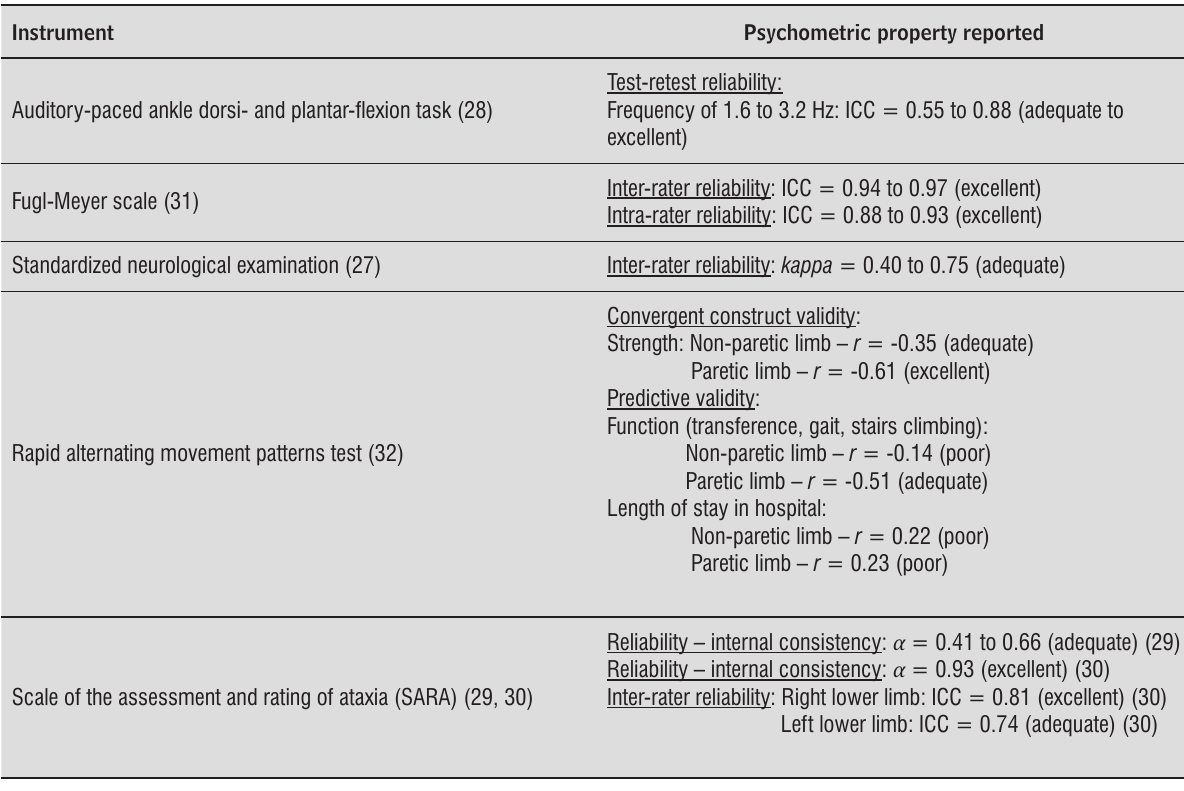
Table 3 - Values of the psychometric properties of the non-specific tests for the evaluation of lower limb motor coordination, reported by the studies included in the review